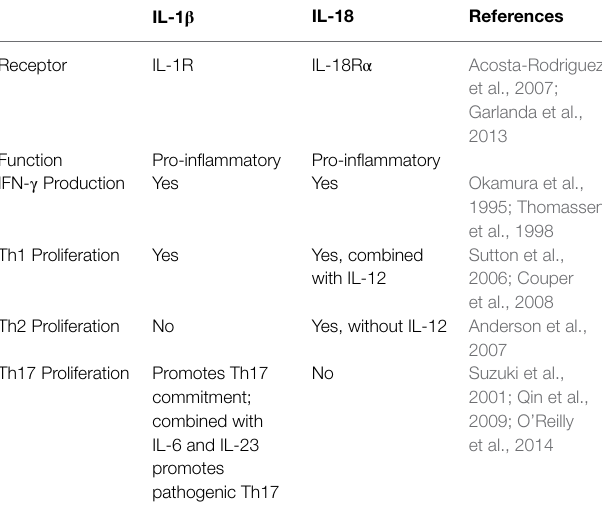
TABLE 1 | IL-1 β and IL-18